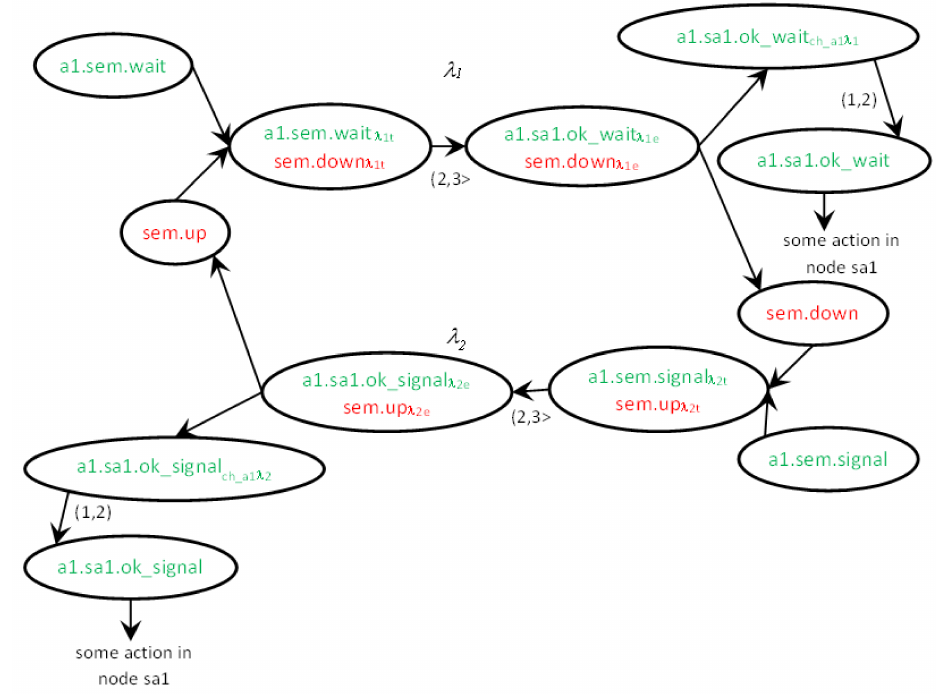
Figure 6. The image of two actions λ 1 = {a1.sem.wait, sem.up} → (2,3>{a1.sa1.ok_wait, sem.down} and λ 2 = {a1.sem.signal, sem.down} → (2,3>{a1.sa1.ok_signal,